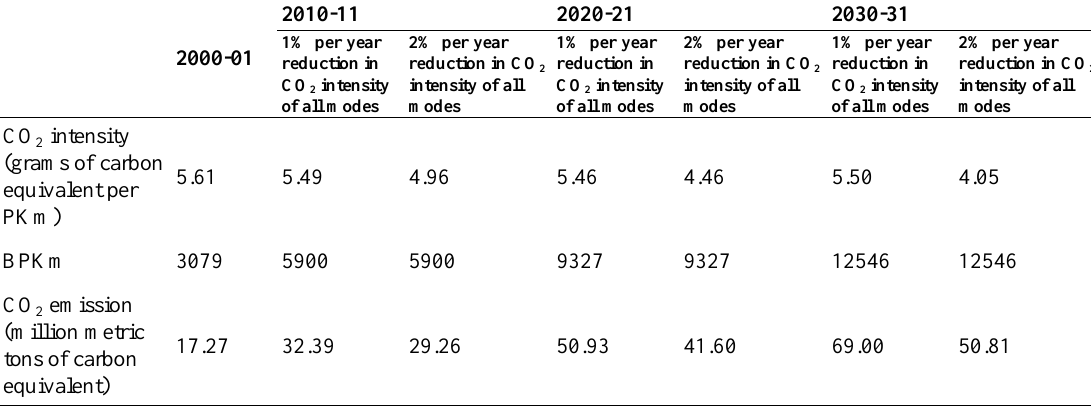
Table 10. The level of CO gain